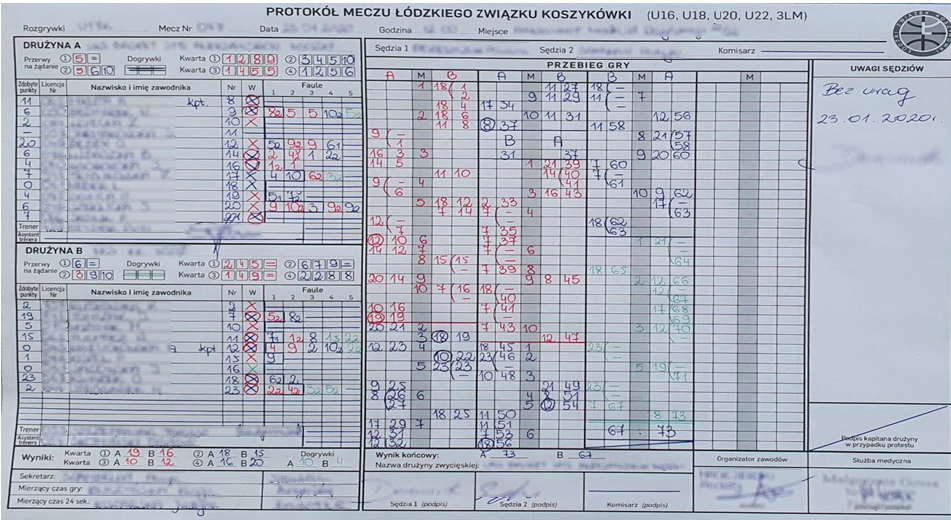
Figure 6. Example of match protocol.